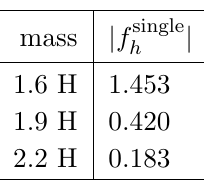
Table 1 . NG mediated by h via single exchange diagram in e(cid:11)ective Goldstone description.